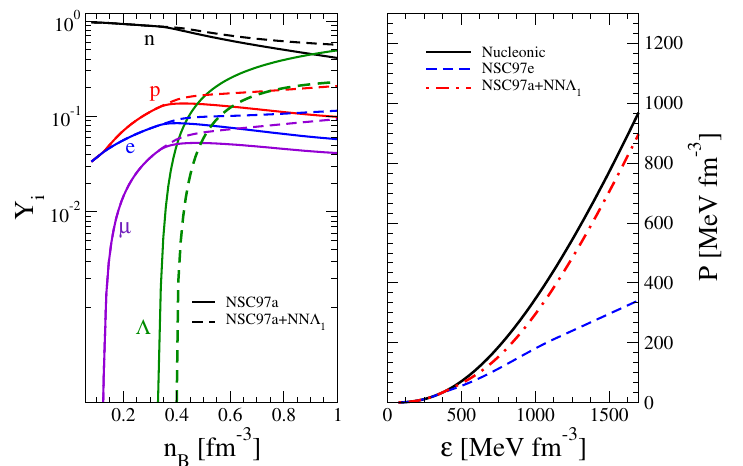
Figure 6. Neutron star matter compositions ( left panel ) and corresponding EOSs ( right panel ) as a function of the baryonic density, for the BHF calculations proposed in Ref. [216]. See text for